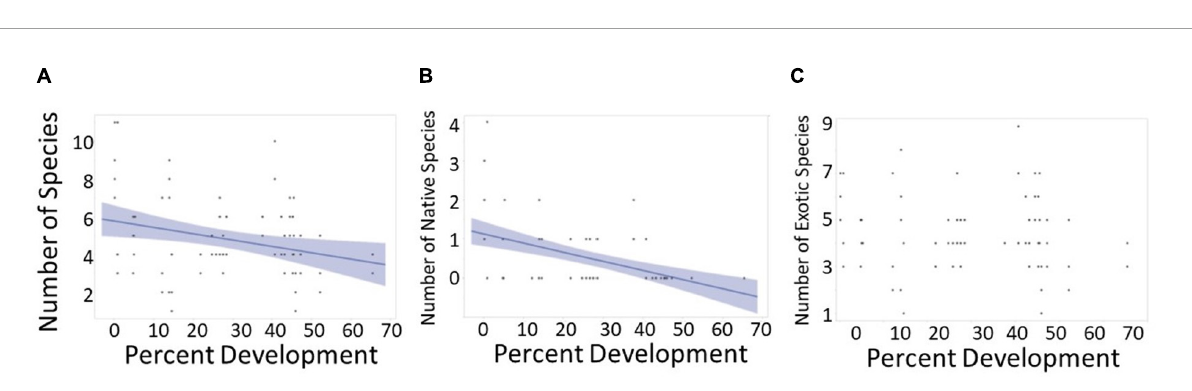
FIGURE3 The effect of number of overall species, native species, and most common exotics vs. percent development. (A) Percent development had an effect on the overall number of species at each quadrat [ F ( 1 , 12 ) = 6.05, p = 0.030]. Spearman’s correlation coefficient showed this to be a weak negative effect ( r s = –0.28, n = 81, p = 0.01]. (B) Percent development had an effect on native species [ F ( 1 , 12 ) = 8.70, p = 0.012] which Spearman’s correlation coefficient found to be a moderately strong negative monotonic correlation ( r s = –0.47, n = 81, p < 0.001). (C) Percent development did not have an effect on exotic species [ F ( 1 , 12 ) = 3.15, p =